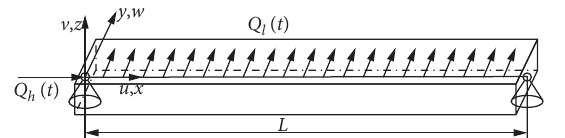
Figure 1: Force analysis on micro-segment of beam under lon- gitudinal and lateral loading.